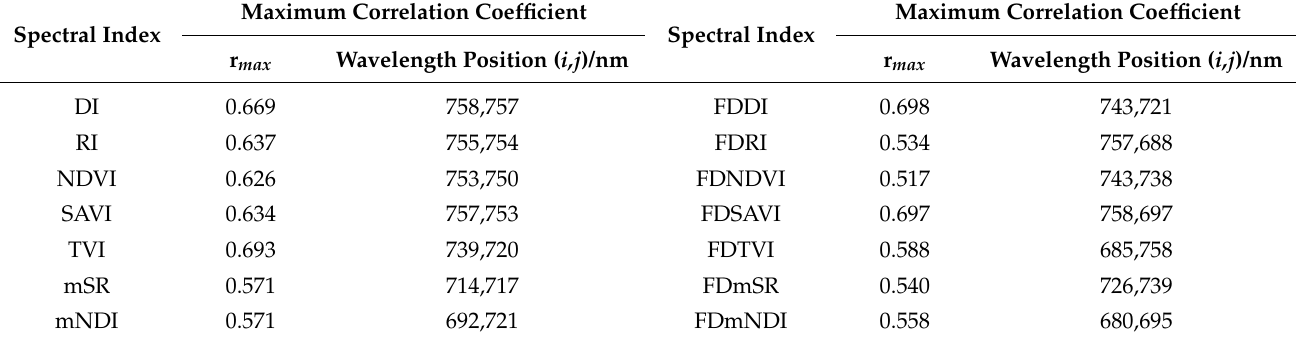
Table 4. The maximum value and wavelength position of correlation coefficient between spectral index and above-ground